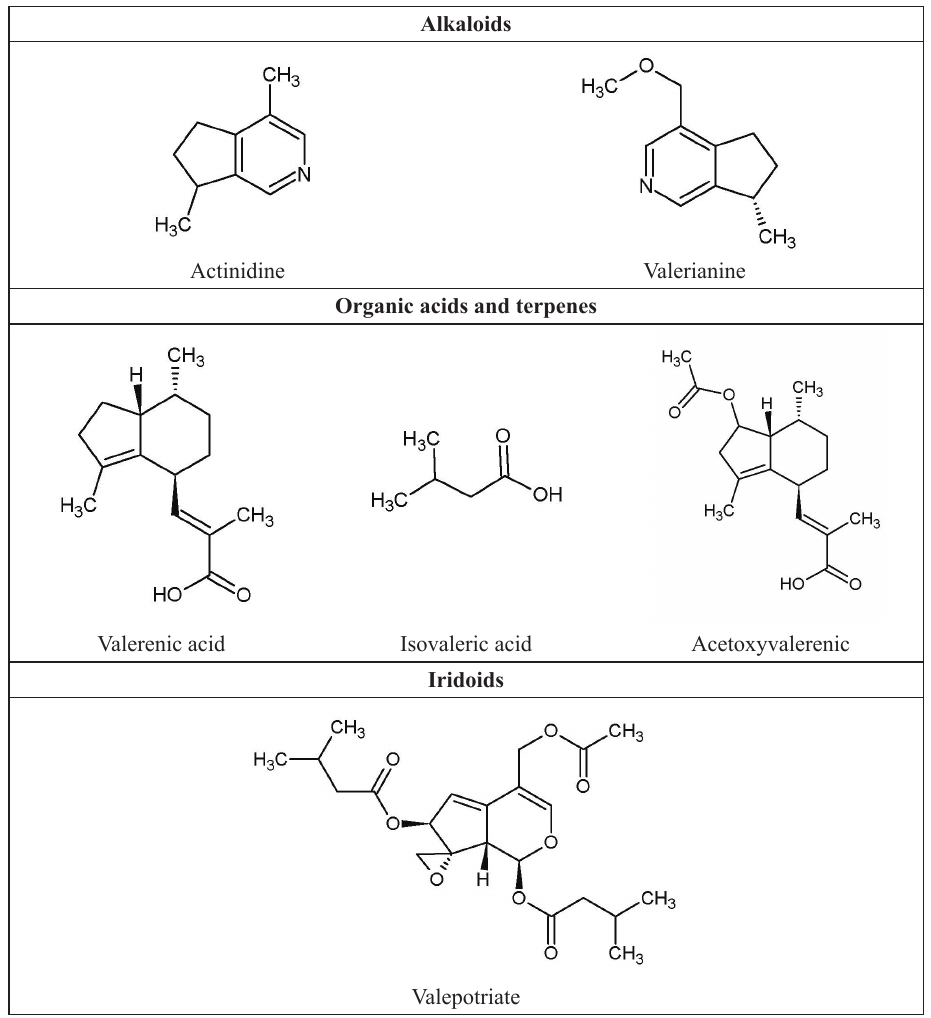
Figure 2. Chemical structures of some principal constituents identified in Valeriana officinalis . Table 1. In vitro biological studies for Valeriana officinalis